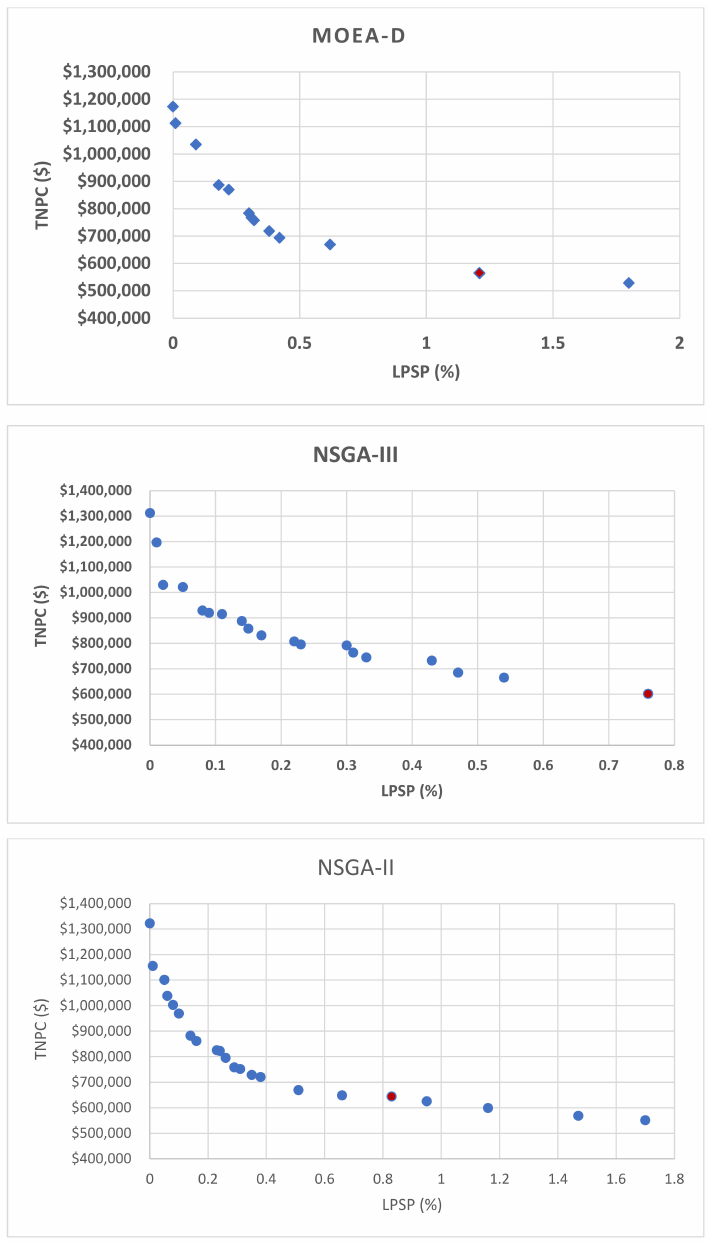
Figure 8. The Pareto front of TNPC vs. LPSP for the suggested four optimization algorithms. The results of the Performance Evaluation metric are displayed as a radar plot (Figure 9), depicting the values of four distinct metrics, convergence, diversity, efficiency, and robustness, for four widely used multi-objective optimization algorithms, namely MOEA-D, NSGA-II, NSGA-III, and MOPSO. The radar plot reveals that the highest overall performance is achieved by NSGA-II, with the best scores for convergence and diversity. NSGA-III has the highest efficiency score, while MOPSO attains the highest diversity score. However, MOEA-D is observed to have the highest robustness score, indicating its suitability for diverse problem conditions. Overall, the radar plot provides a graphical representation of the strengths and weaknesses of the four algorithms based on the selected metrics, facilitating the selection of an appropriate algorithm for a given multi-objective optimization